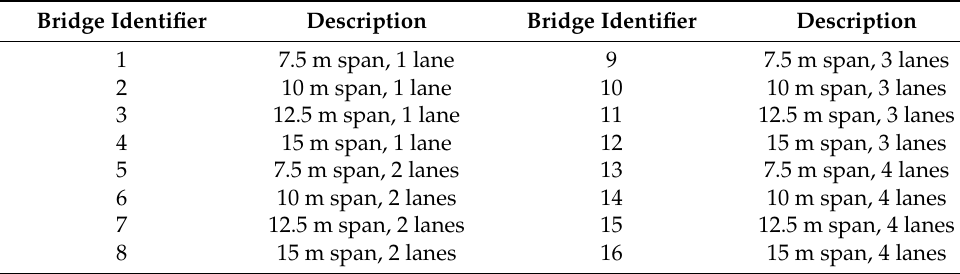
Table 7. Description of bridge identifiers for Figures 12 and 13 and Tables 8–10.